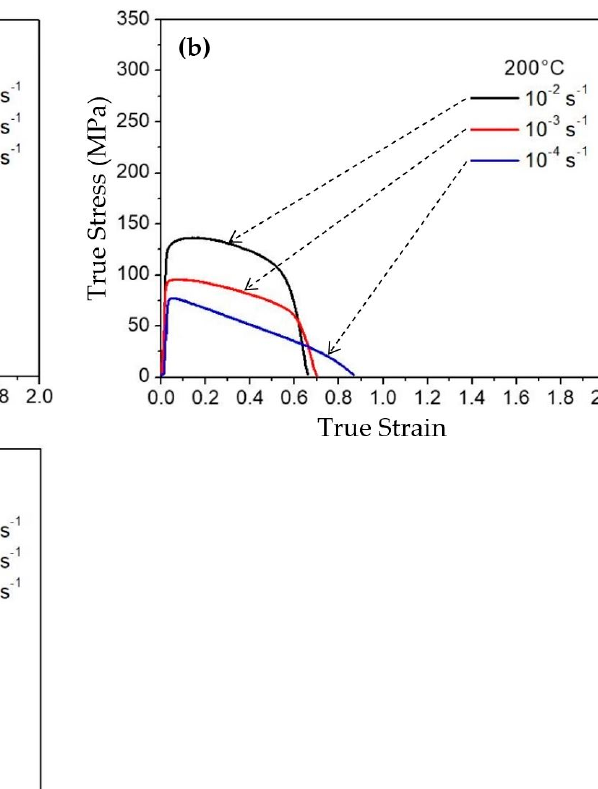
Figure 5. True stress–true strain curves at different temperatures and strain rates: ( a ) 150, ( b ) 200, and ( c ) 250 °C.